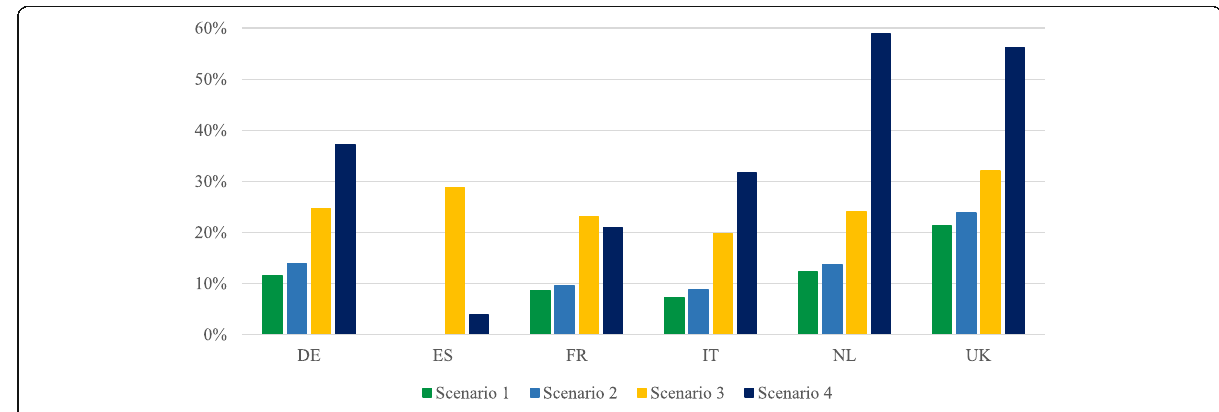
Fig. 18 Population covered (%) under the four scenarios: the case of Germany, Spain, France, Italy, The Nederland, and the